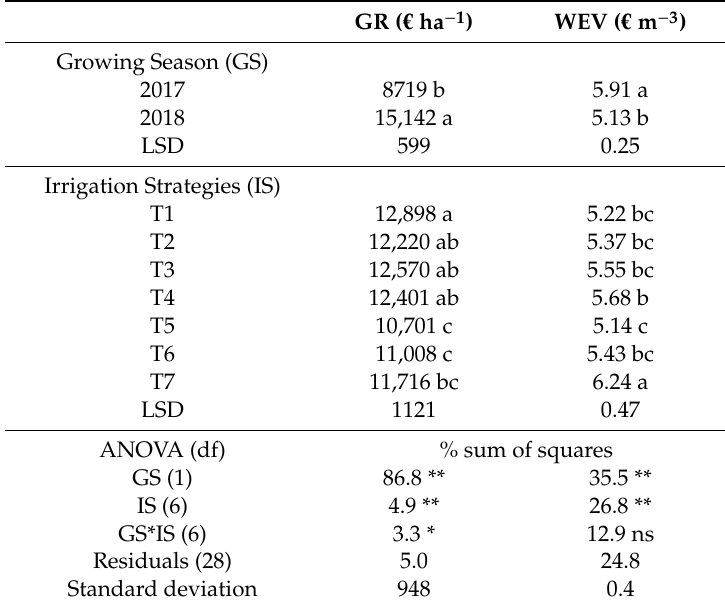
Table 8. E ff ects of the growing season and the irrigation strategy on the gross revenue (GR) and water economic value